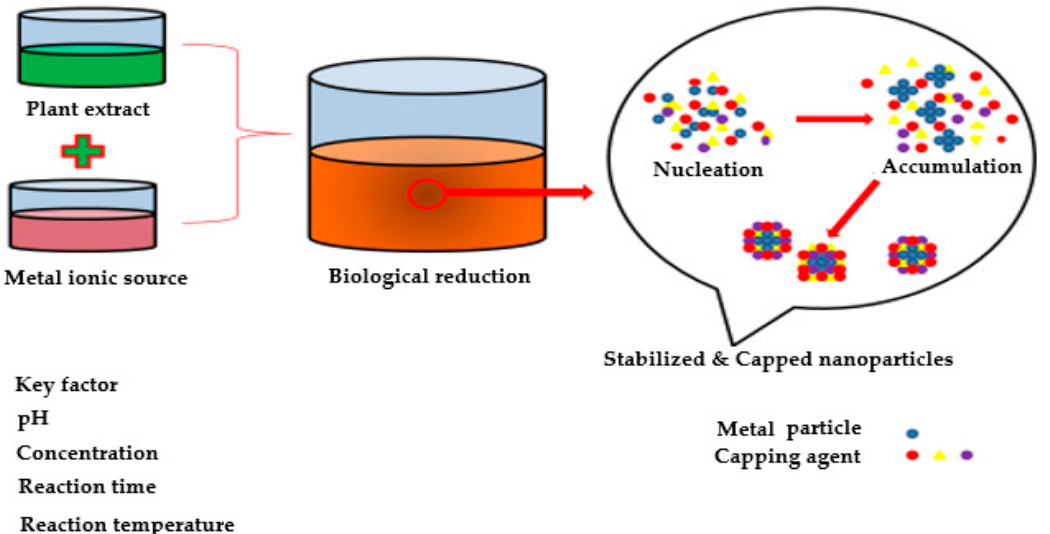
Figure 2. Biological synthesis of nanoparticles by using plant